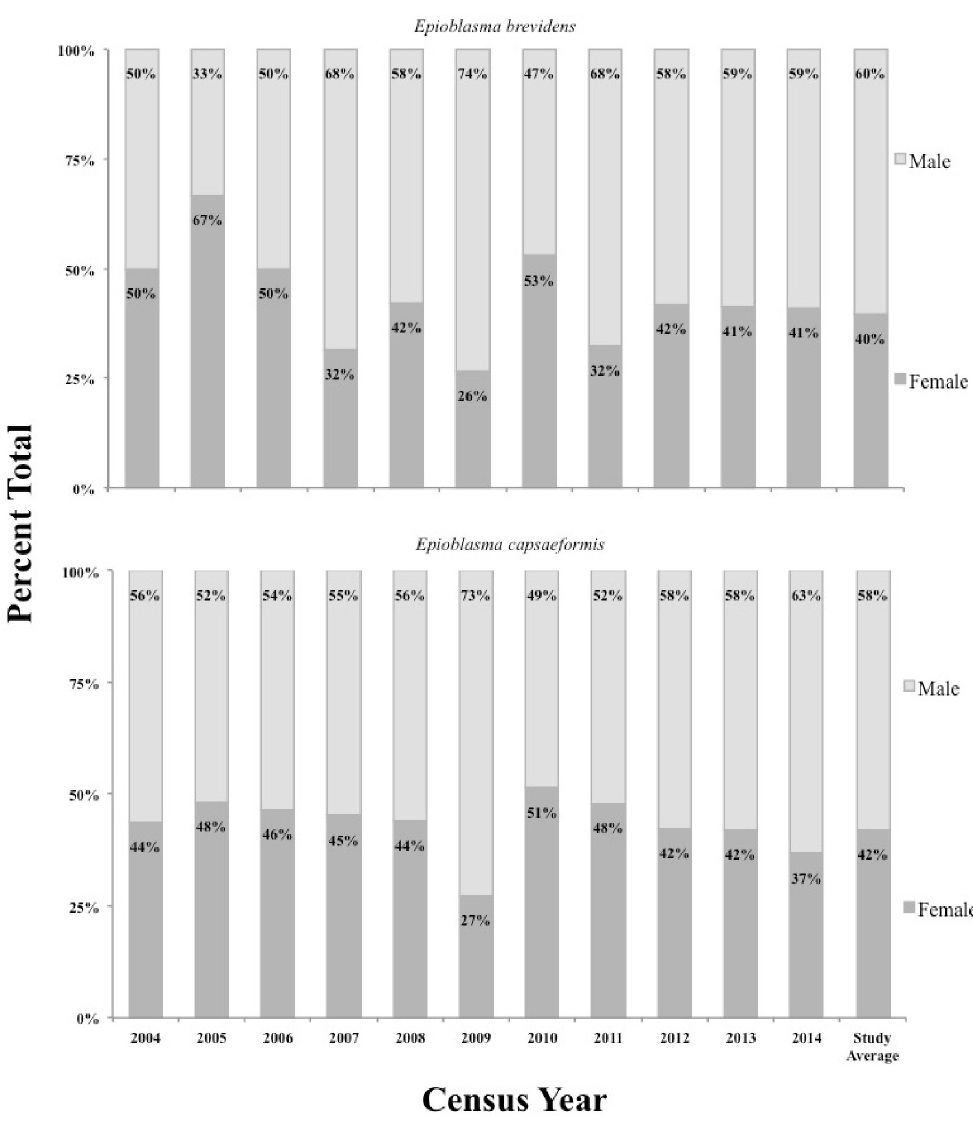
Fig 7. Sex-ratios observed from all quadrat samples of Epioblasma brevidens and E . capsaeformis at Swan Island, Frost Ford, and Wallen Bend in the Clinch River, TN, from 2004–2014. Calculations do not include individuals too small to differentiate